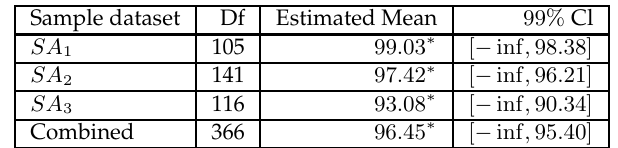
Figure 9: Boxplots of the accuracy distribution of individual and combined datasets (red- dotted line y = 90% ).